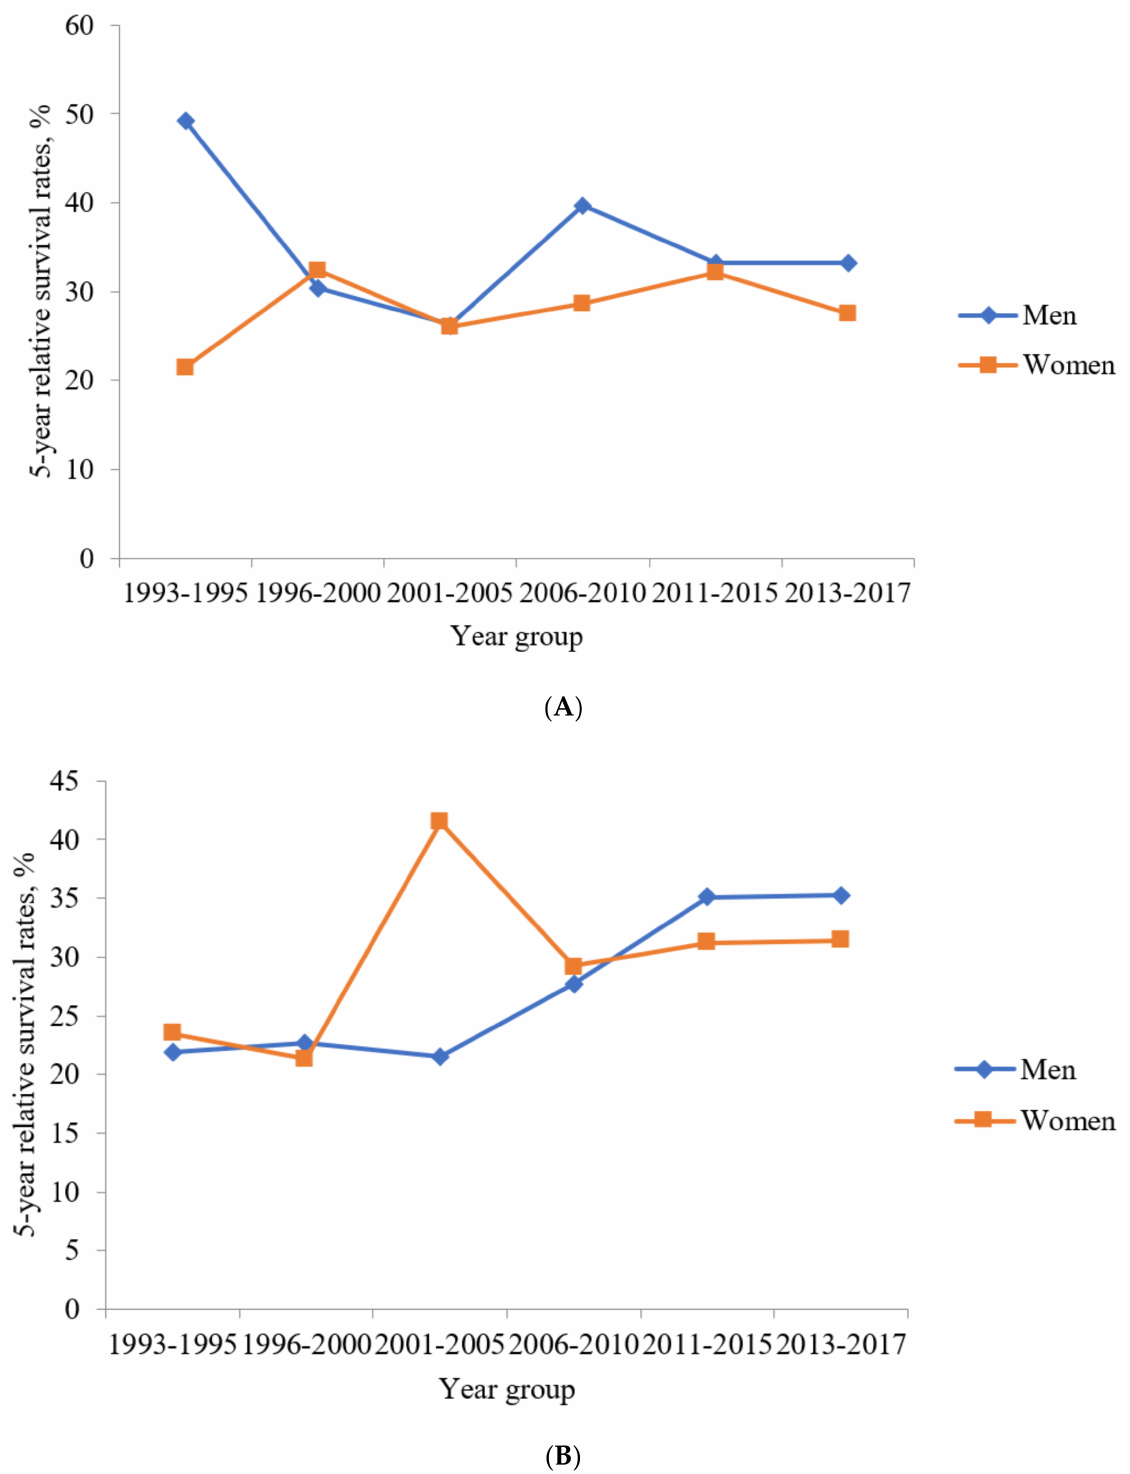
Figure 4. The five-year relative survival rates of patients with colorectal signet-ring cell carcinoma in different time